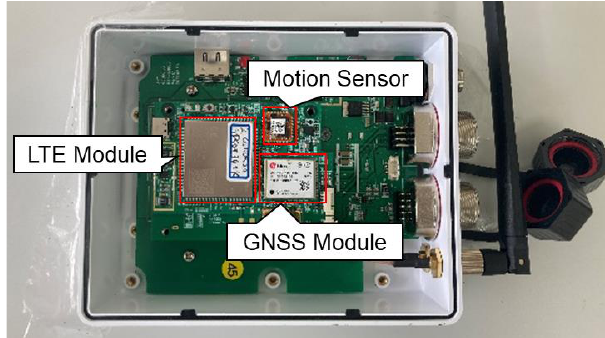
Figure 6. Autonomous driving hardware.